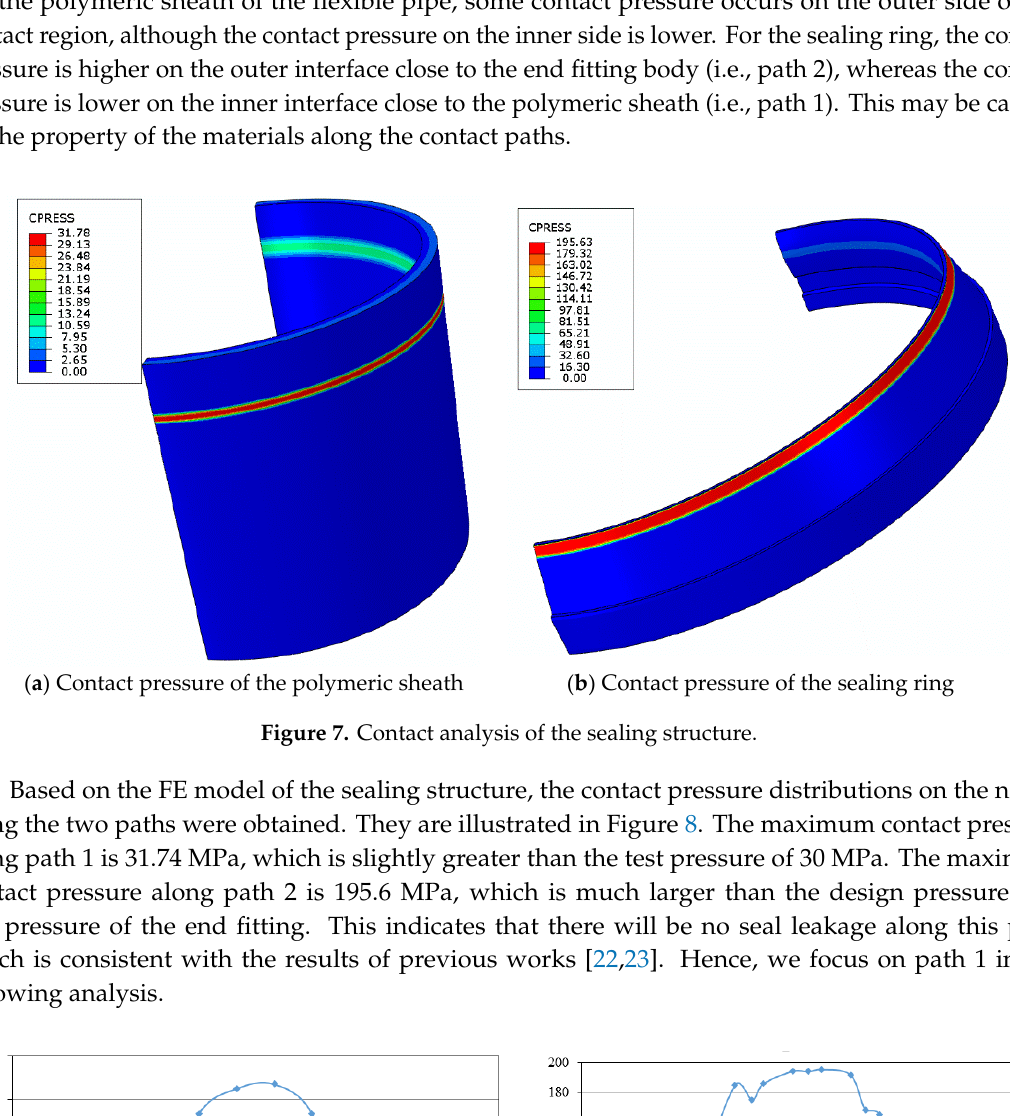
Figure 8. Comparison of the sealing performance along the two paths.